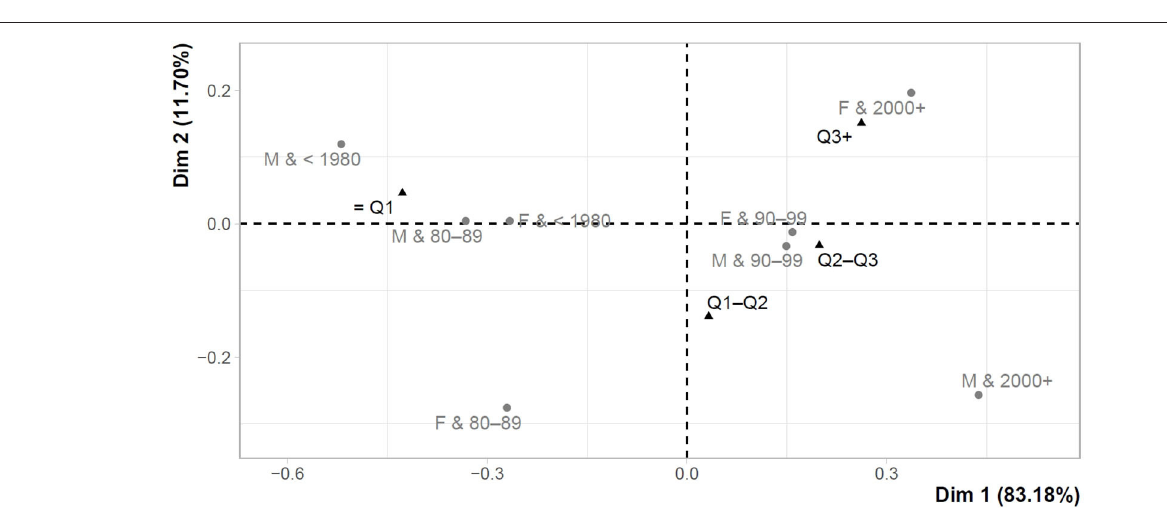
FIGURE 3 | Correspondence map–Perc_test T2 and gender-age